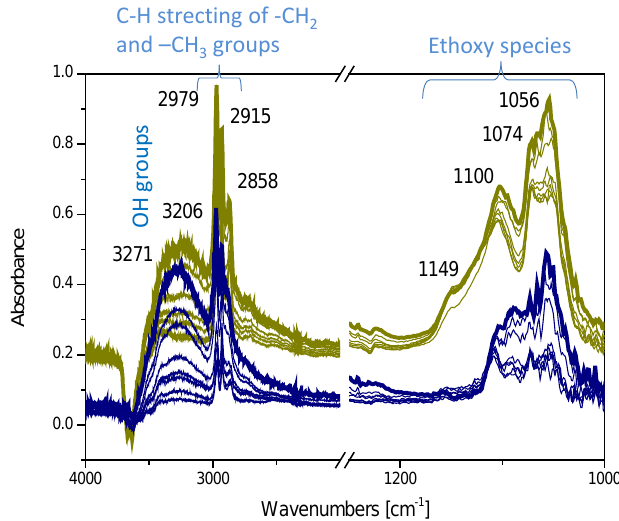
Figure 9. Comparison among the FTIR spectra collected upon 5 mbar ethanol adsorption and at decreasing CO pressures at r.t. on I1.0Cu/P25 (dark yellow curves) and D1.0Cu/P25 (blue curves).